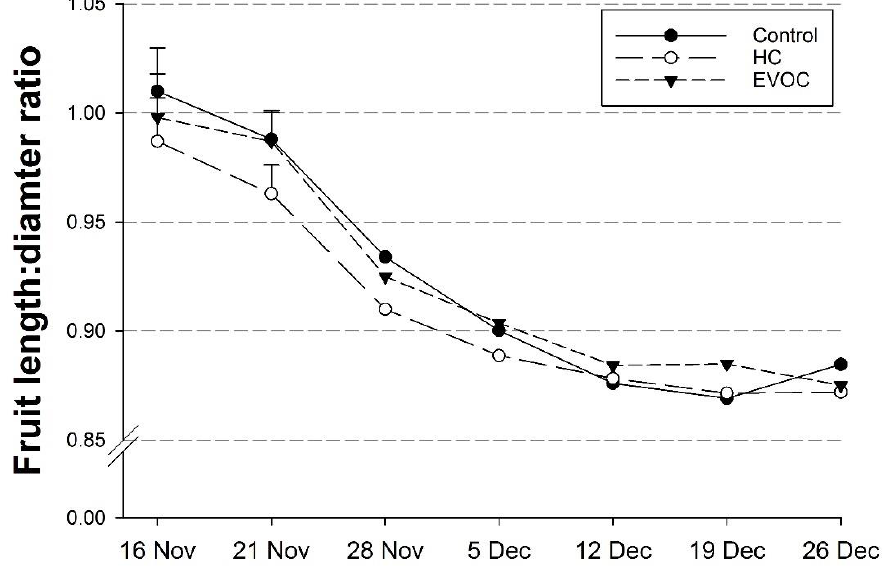
Figure 8. Changes in fruit shape (length:diameter ratio) of the sweet cherry cultivar ‘Lapins’ from straw stage to commercial harvest. Error bars are the least significant differences ( p < 0.05).